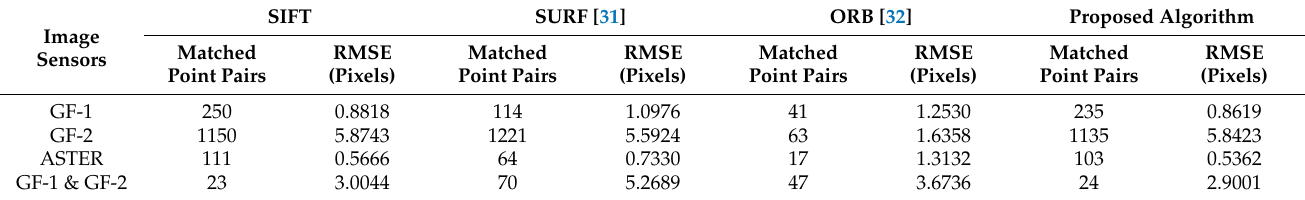
Table 5. Registration performance comparison of different